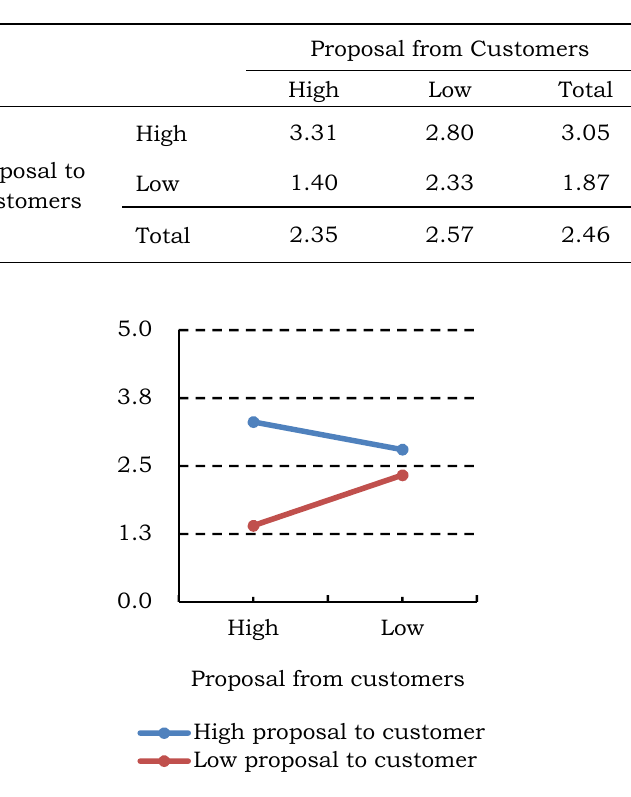
Table 6. Average return on sales of high DC group